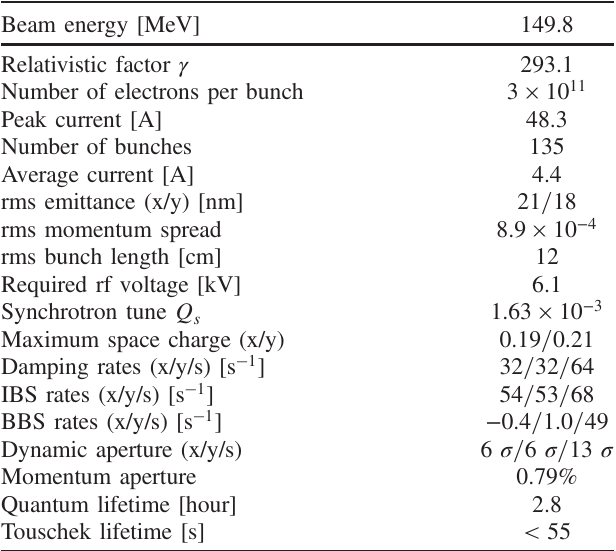
TABLE III. Electron beam parameters in the ring cooler.